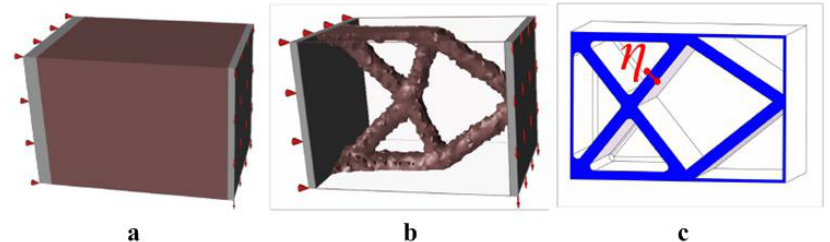
Figure 13. The original cuboid model ( a ), rectangular frame obtained by topology optimization ( b ), the final rectangular frame after optimization ( c ).